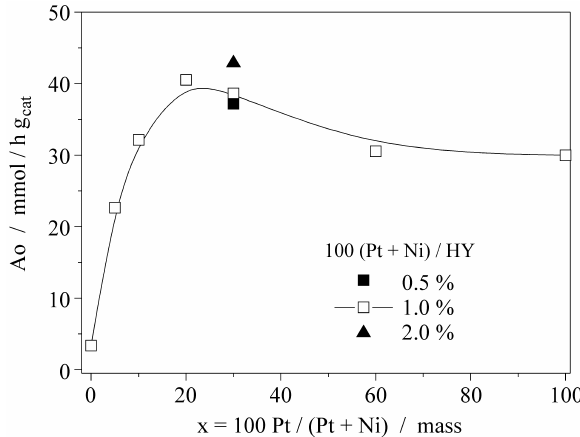
Figure 5. Initial activity (Ao) of catalysts 1% (Ni + Pt)/HY as a function of the platinum